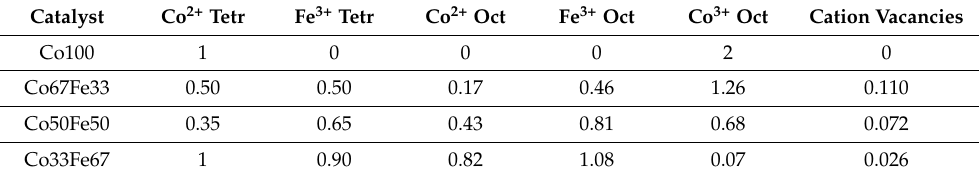
Table 7. Cation distribution per 4 oxygen atoms in cobalt-iron spinel phases.